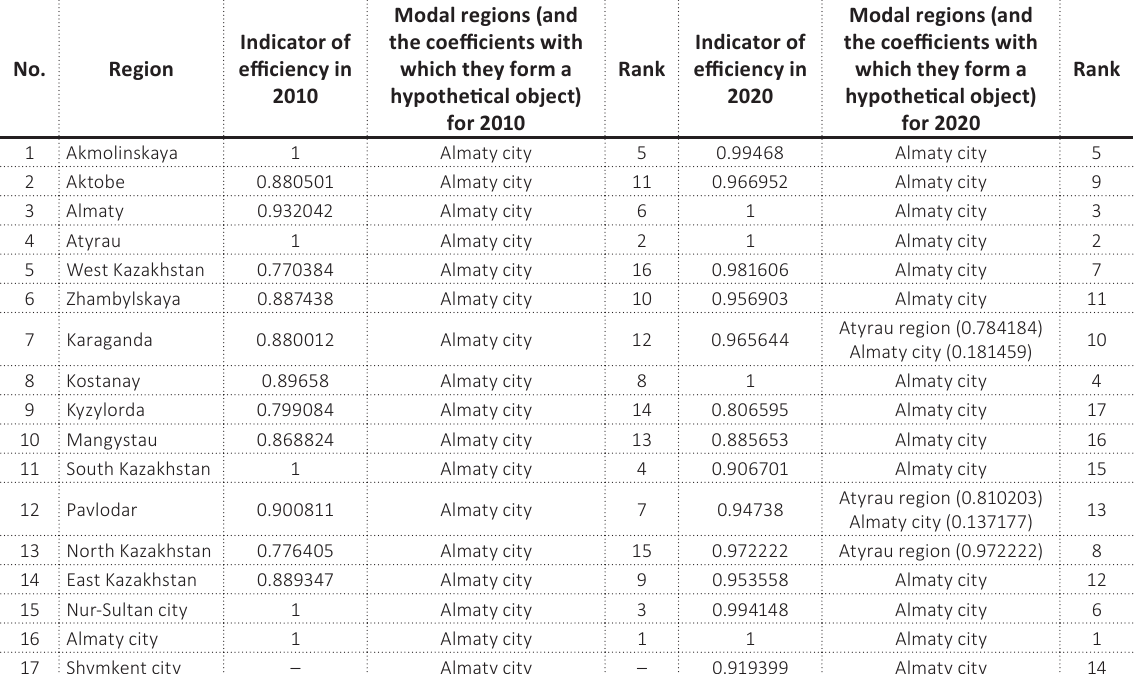
Table 2. Performance evaluation result and benchmarkable regions for 2010 and 2020